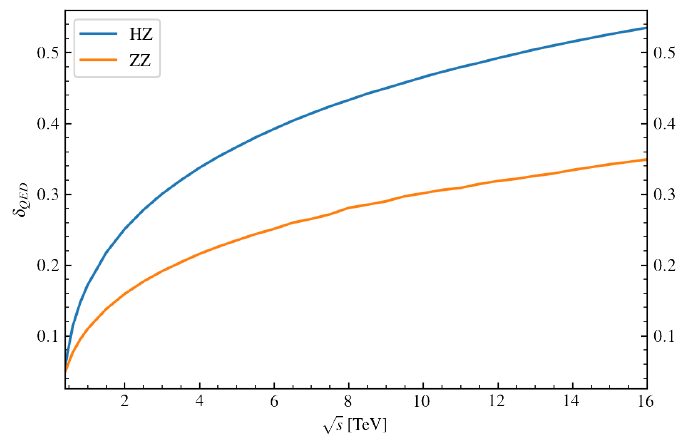
Figure 4 . Relative QED corrections δ QED = σ incl muon collider as a function of the collider energy,